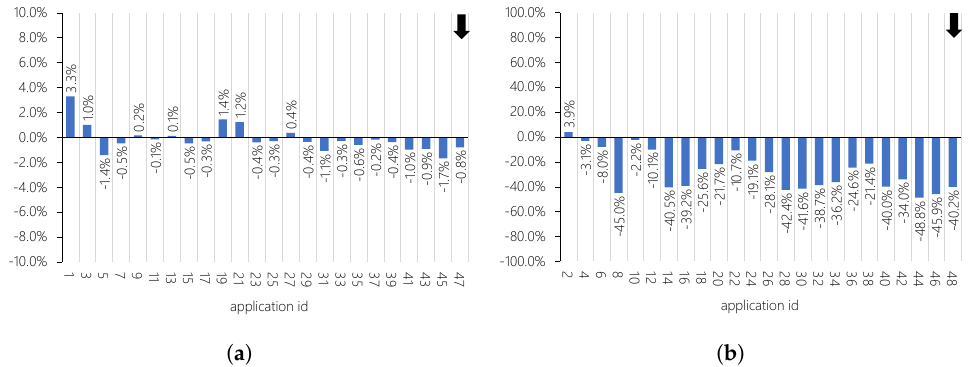
Figure 7. Variation in the average delay of each application. The figures represent the results for the applications that consume depth data ( a ) and position data ( b ). The black arrow represents the direction for better results.